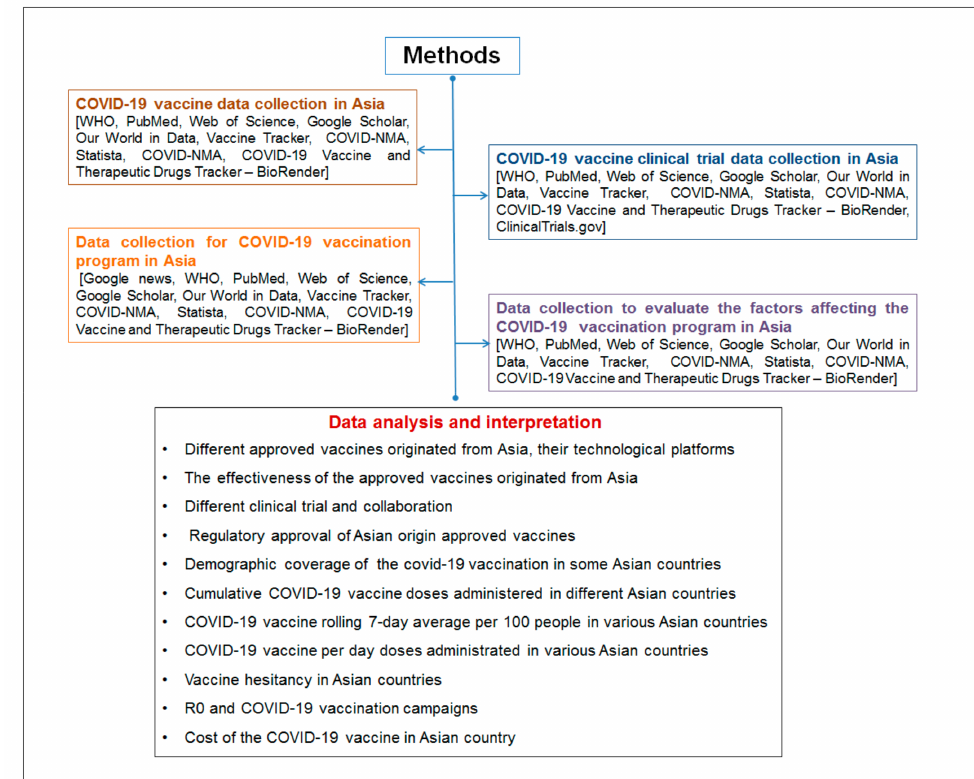
Figure 1. A flowchart describing the methodology of this